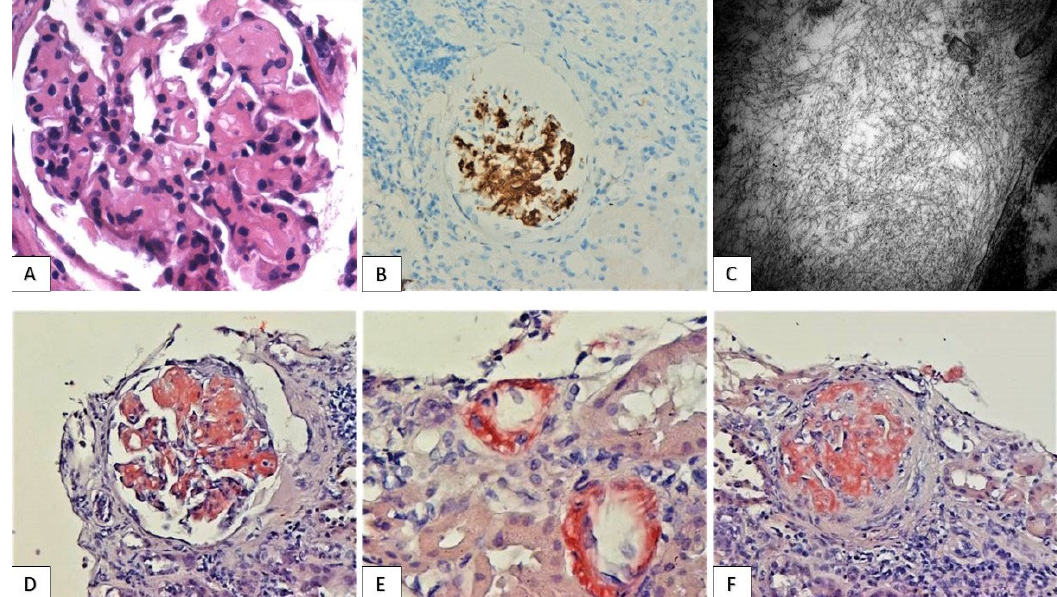
Figure 5. Secondary AA amyloidosis: Glomeruli displayed expansion of the mesangial area, which was occupied by acellular eosinophilic aggregates (( A ): H&E ×400). These amorphous aggregates stained positively for Congo ‐ Red (( D , F ): ×200) and demonstrated strong diffuse immunoreactivity for amyloid A protein (AA) (( B ): Amyloid A protein ×200). Similar Congo ‐ Red reactive eosinophilic deposits were detected on arterioles and interlobular arteries (( E ): ×400). (( C )): electron microscopy shows randomly arranged, non ‐ branching fibrils (×44,000).